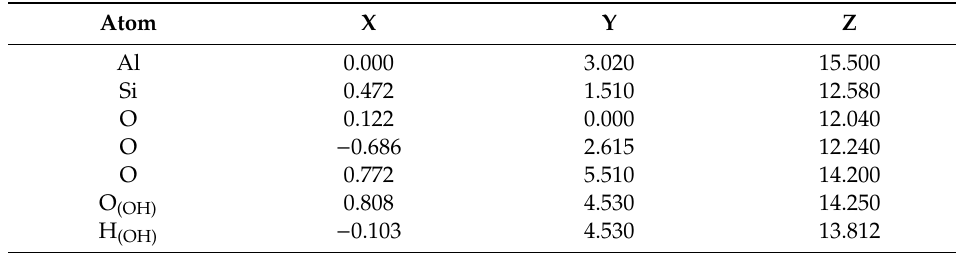
Table 3. Atomic coordinates of